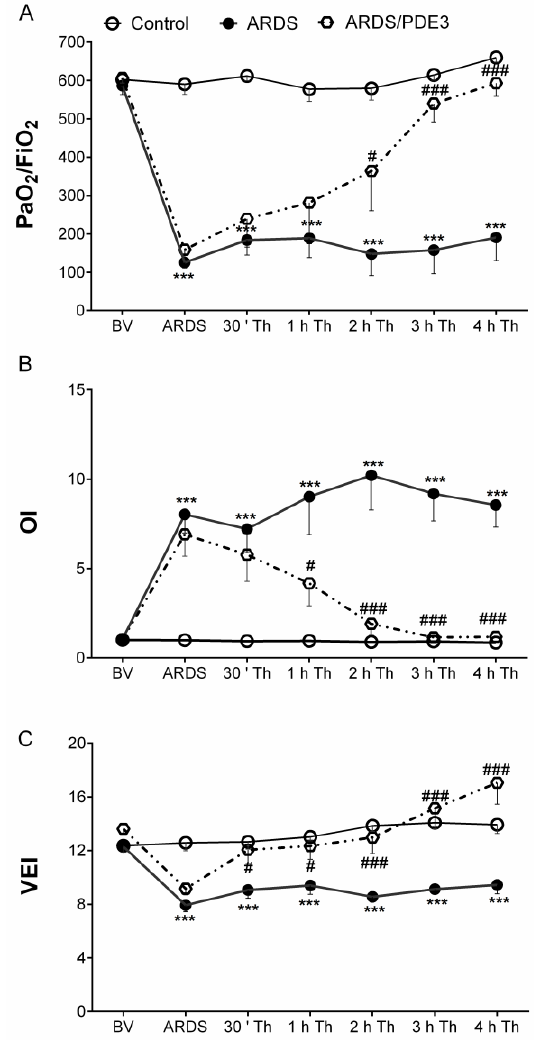
Figure 5. Changes in gas exchange indexes during the experiment. ( A ) The ratio of arterial oxygen partial pressure to the fraction of inspired oxygen (PaO 2 /FiO 2 ); ( B ) oxygenation index (OI), and ( C ) ventilation efficiency index (VEI) before (basal value, BV) and after lung lavage (ARDS) , 30 min (30′) after ARDS and therapy (Th) administration during 4 h (h) of the experiment in healthy ventilated and non-treated animals (Control group), in non-treated animals with ARDS (ARDS group) and animals with ARDS treated with olprinone (ARDS/PDE3 group). Statistical comparisons: for ARDS vs. Control *** p < 0.001; for ARDS/PDE3 vs. ARDS # p < 0.05, ### p < 0.001. Data are presented as means ± SEM.